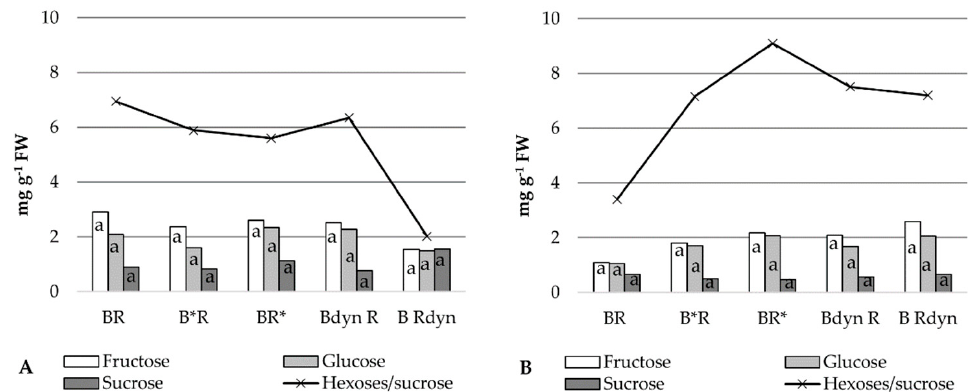
Figure 3. Soluble sugar contents in green ( A ) and red ( B ) lettuce leaves, illuminated with constant and dynamic intensities of red 662 nm and blue 452 nm light. Di ff erent letters indicate statistically significant di ff erences between means according to the Duncan’s multiple range test at the confidence level p = 0.05. Table 3. The antioxidant properties of red and green lettuce leaves, illuminated with constant and dynamic intensities of red 662 nm and blue 452 nm light. Di ff erent letters indicate statistically significant di ff erences between means according to the Duncan’s multiple range test at the confidence level p = 0.05.